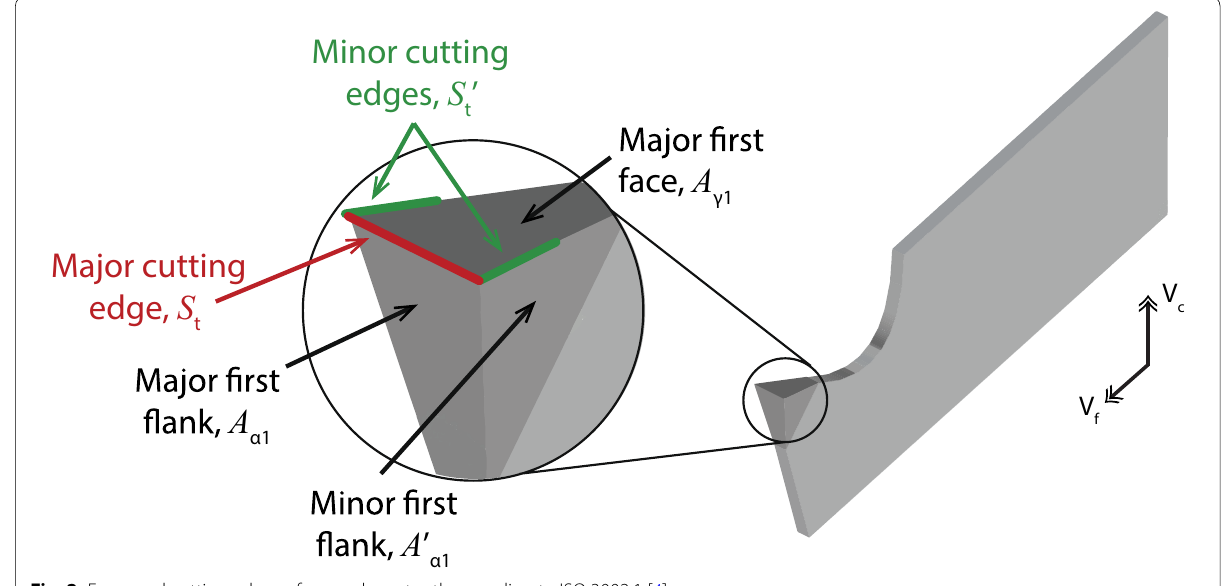
Fig. 2 Faces and cutting edges of a wood saw tooth according to ISO 3002:1 [4]